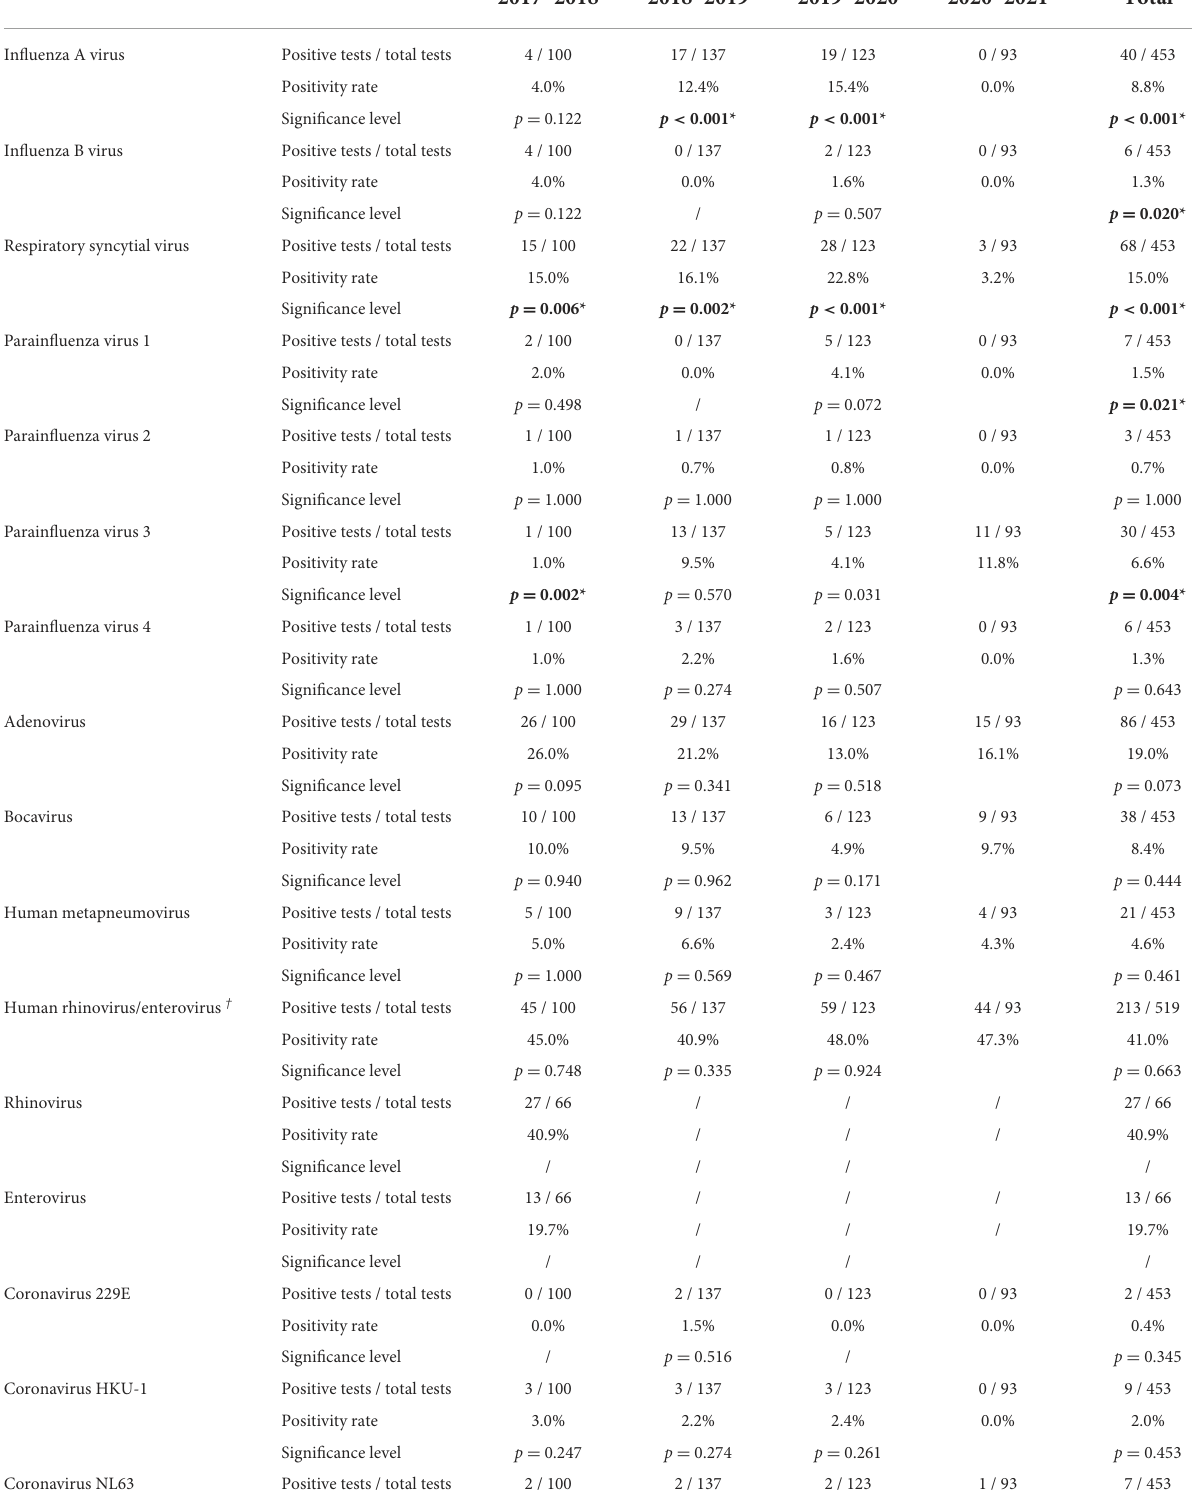
TABLE 3 Annual number and percentage of positive tests for each investigated respiratory